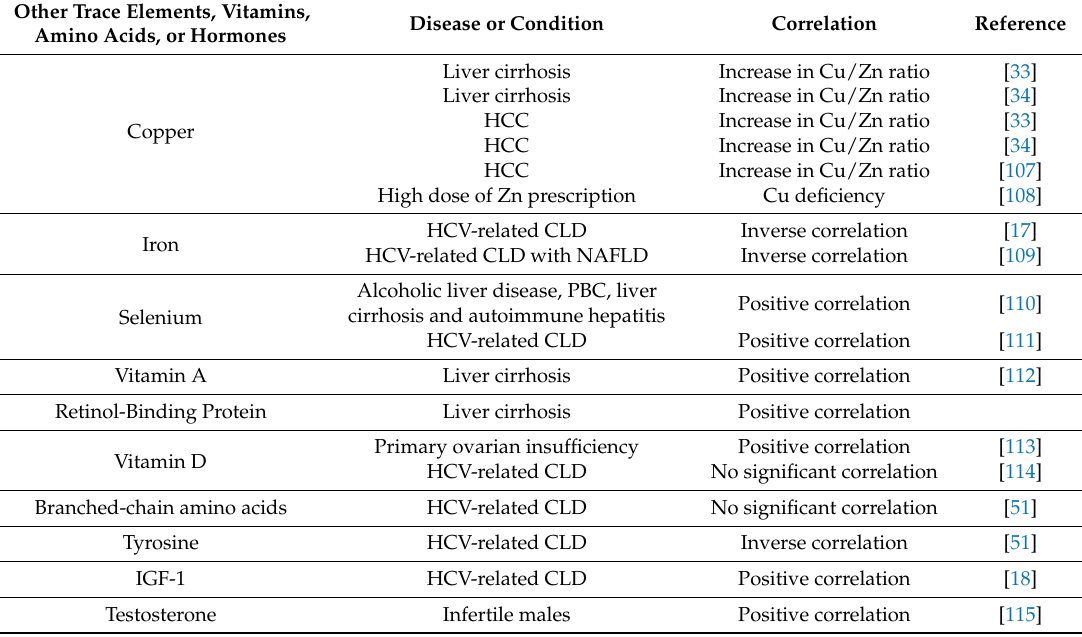
Table 3. Interactions between zinc and other trace elements, vitamins, amino acids, or hormones in chronic liver